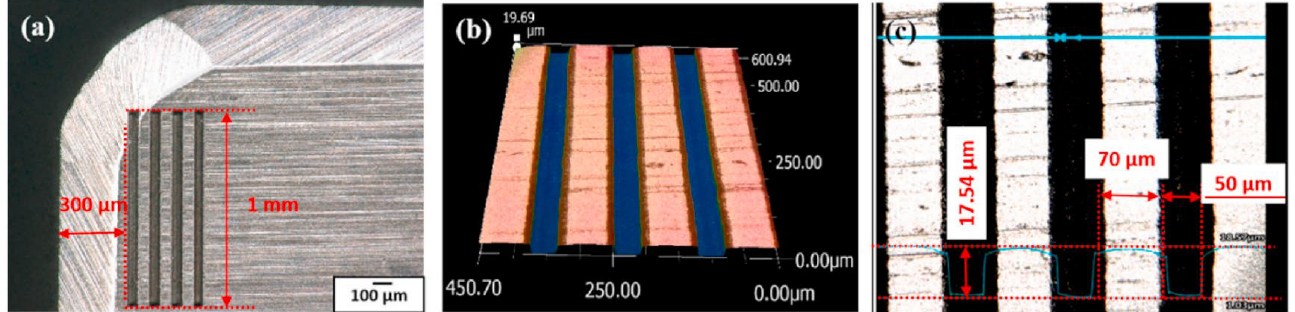
Figure 9. Optical and three-dimensional images of the micro-textured tool ( a ) shows the location of the microgroves on the rake face; ( b ) shows the 3D surface scanning of the microgroves; ( c ) shows the three-dimensional size of the microgrooves [76].